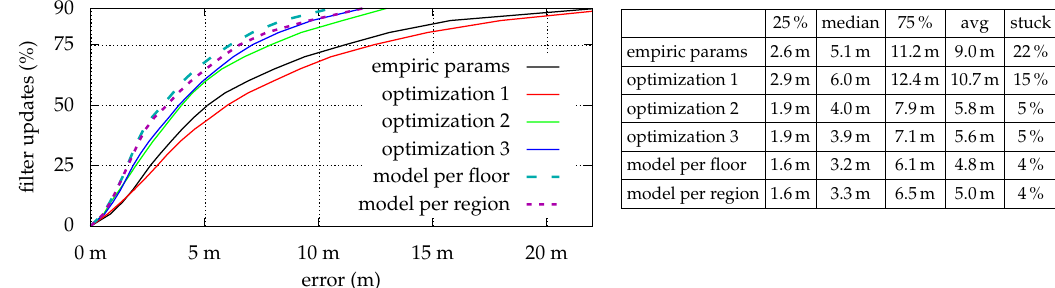
Figure 10. Cumulative error distribution for each model when used within the final localization system from Equation (1). The error between ground truth and estimation is calculated for each filter update, every 500ms. Especially optimization 1 suffered from over-adaption and thus provided worse results. Compared to just using Wi-Fi (Figure 8) the error difference between the models now is much more distinct. Starting from optimization 2 the system rarely gets stuck and provides a viable